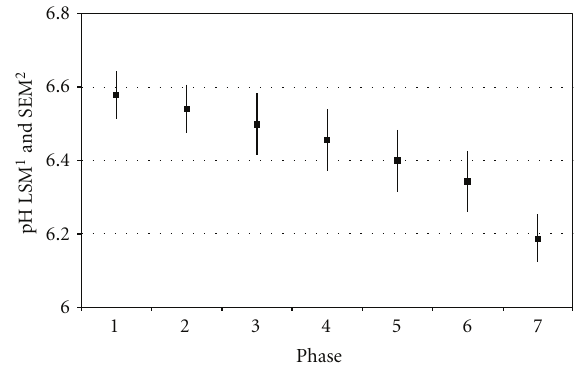
Figure 2: Diurnal patterns of mean reticuloruminal pH of cows from group G and GC (20 hours grazing per day) between day 25 and day 30 with the diet change of group GC to additional concentrate feeding (GC) on day 27, whilst group G was still receiving only pasture (20h/d). Group GH is not shown in this figure due to clear